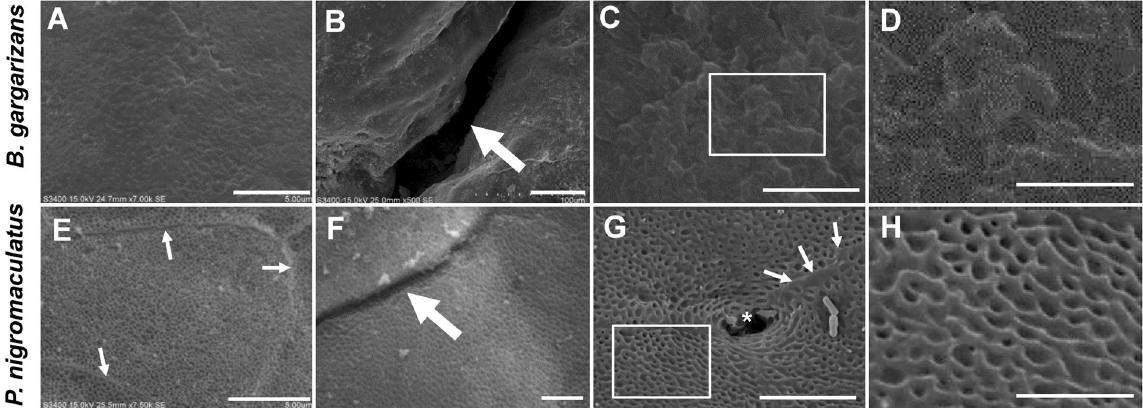
Figure 7. The surfaces of the dorsal skin in B. gargarizans and P. nigromaculatus by SEM. SEM observations of the dorsal skin in B. gargarizans , P. nigromaculatus . Horny surface ( A,C,D ) and shards ( D ) in the dorsal skin of B. gargarizans . ( B ) Deep groove of the dorsal skin, boundary among stratum corneum cells ( E,G ), shallow groove ( F ), and regular ring structure ( G,H ) in the dorsal skin of P. nigromaculatus . The white thick arrow shows the groove, and the white thin arrow shows the boundary among stratum corneum cells. D and H show enlarged images of the boxes in C and G, respectively. Scale bar, A, C, E, G: 5 μ m; B, F: 50 μ m; D, H: 2 μ